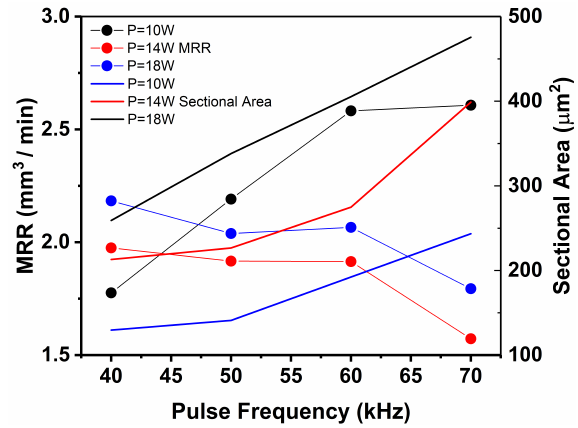
Figure 9. Effect of laser power and pulse frequency on MRR. Table 7. ANOVA results of